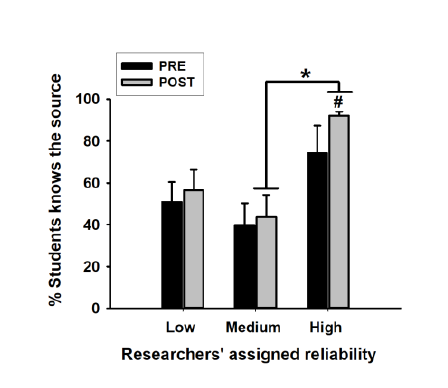
Figure 1. Percentage of students who knows the information source (Mean ±